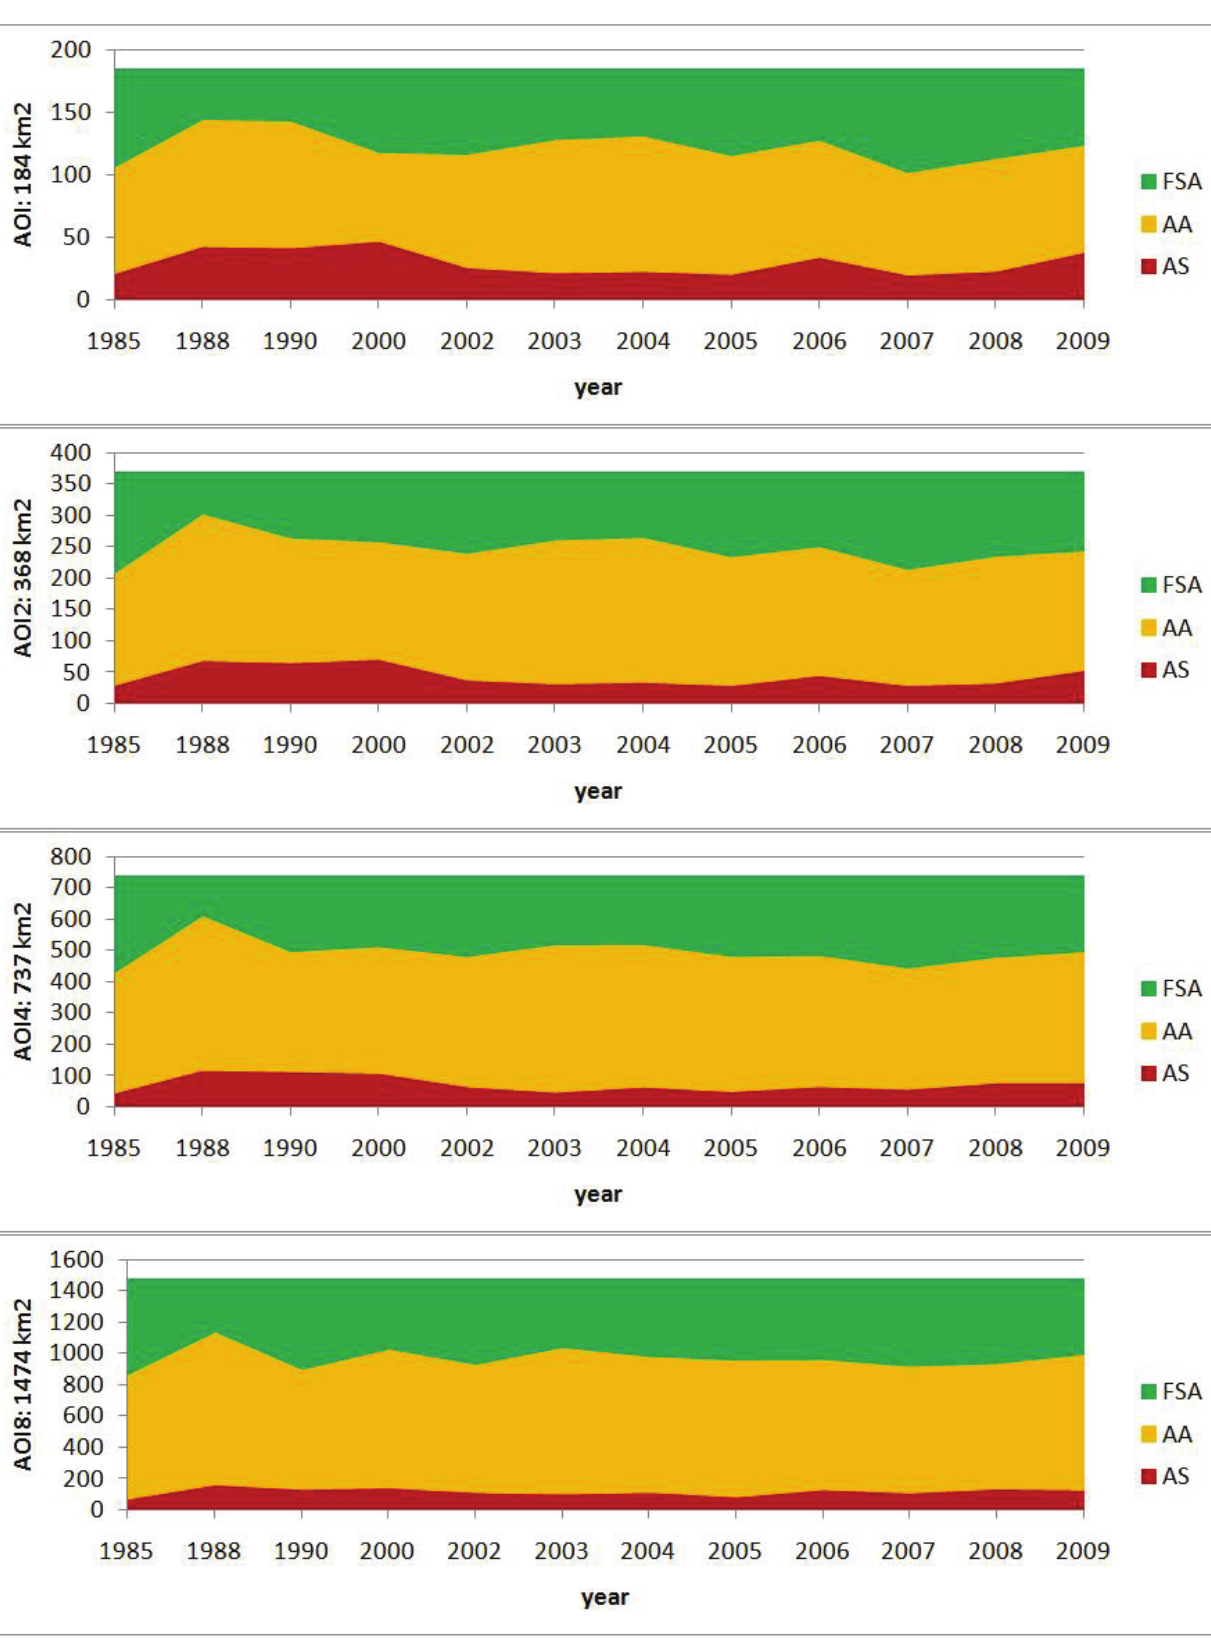
Figure 9. Land-cover changes in the AOIs (AOI, AOI2, AOI4, and AOI8) as a result of large scale mining in the 1985–2009 period; land changes in the local scale of mining areas (AOI) show higher disturbances of crop lands represented by agricultural